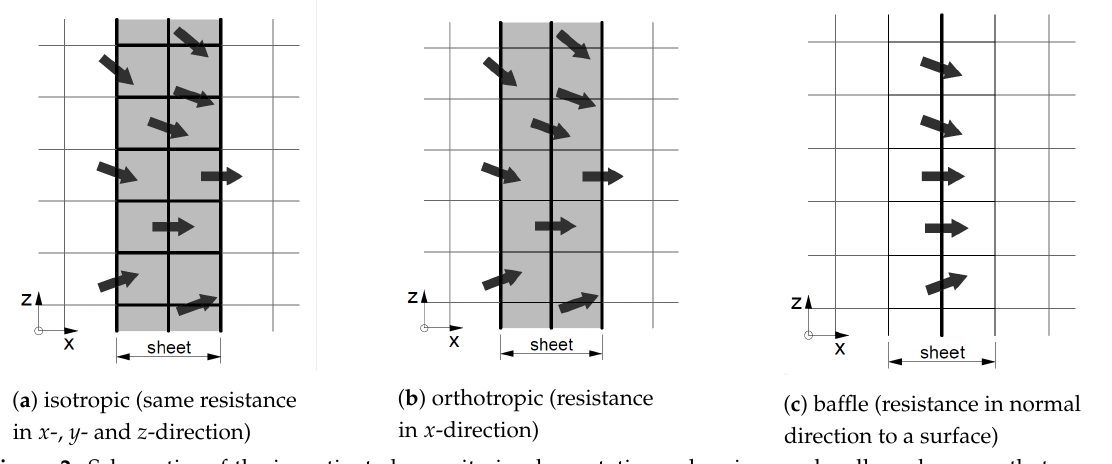
Figure 2. Schematics of the investigated porosity implementations, showing mesh cells and arrows that represent the velocity vectors close to a porous sheet; bold lines along the cell faces indicate the components of the velocity that are subject to a pressure-drop; shades represent porous-media zones. ( a ) isotropic (same resistance in x -, y - and z -direction) ( b ) orthotropic (resistance in x -direction) ( c ) baffle (resistance in normal direction to a